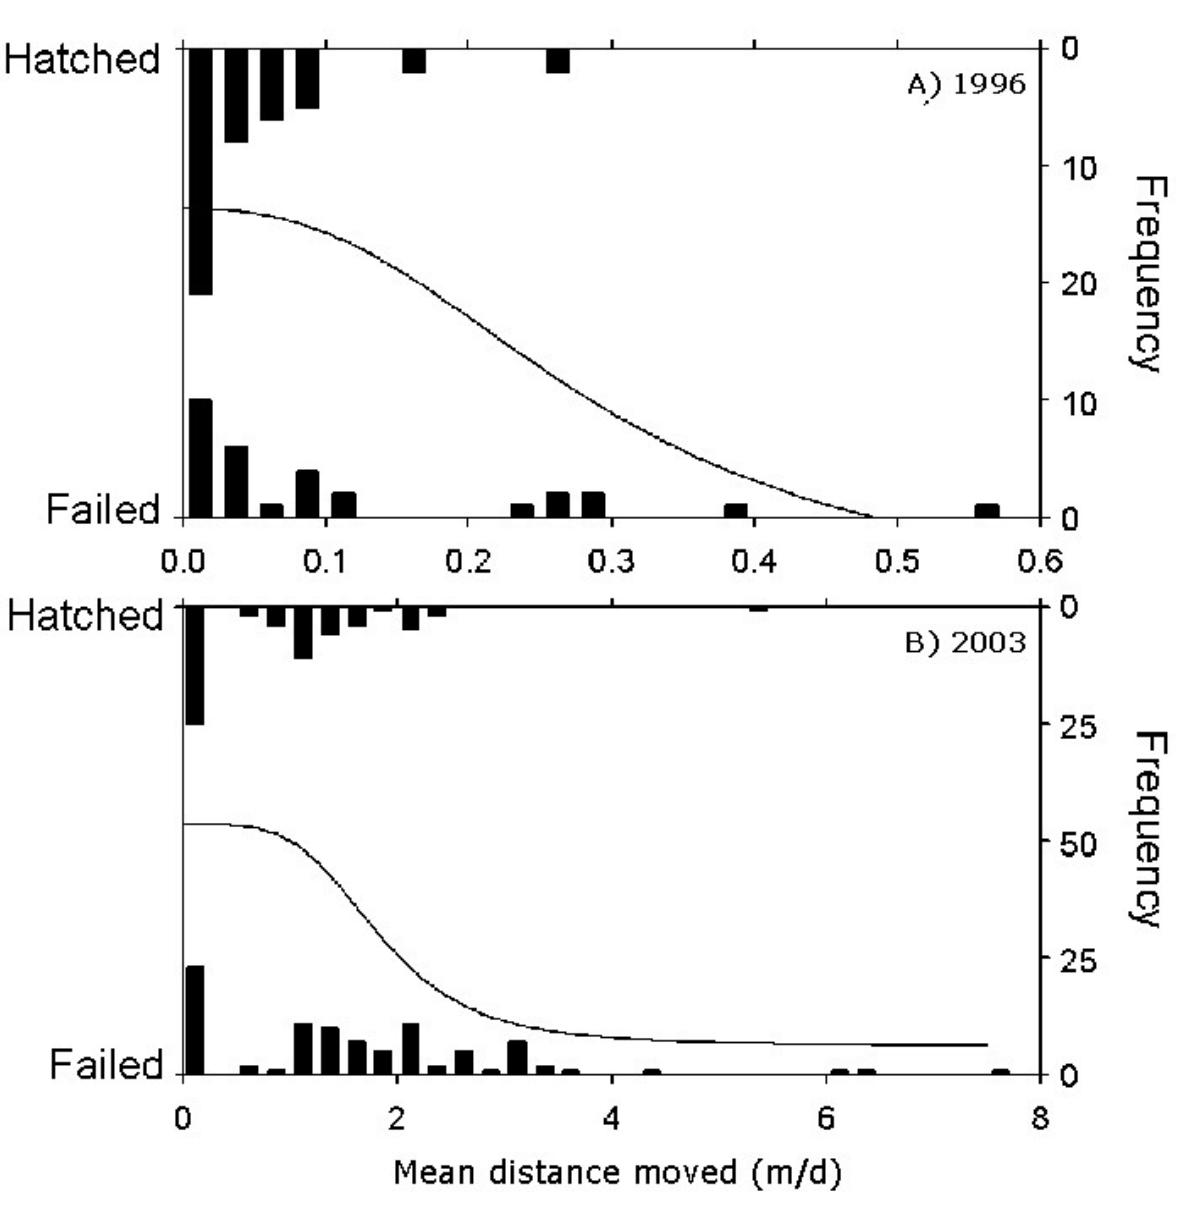
Fig. 4 . Logistic regression of hatching fate on distance of average daily movement for 75 nests in 1996 and 153 nests in